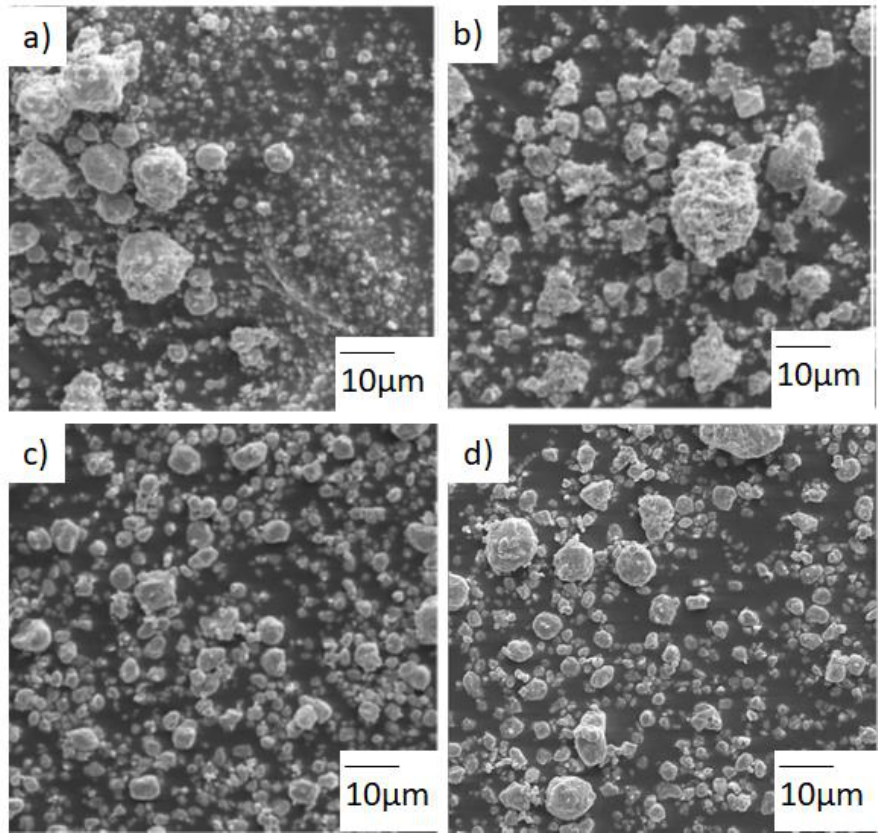
Figure 3. SEM micrographs after 80 h milling of samples: ( a ) P7-A, ( b ) SPEX-A, ( c ) P7-B, and ( d ) SPEX-B.